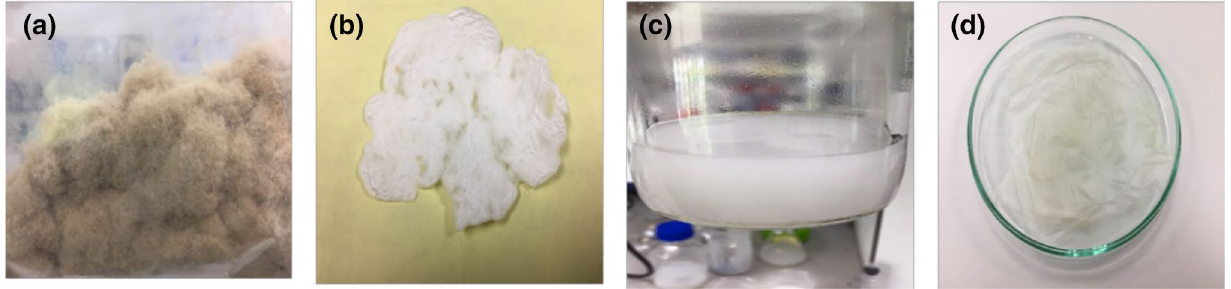
Fig. 1 Photographs of various forms of water hyacinth during the preparation a the cut and ground fibers, after washing with methanol, b the NaOH-extracted and H 2 O 2 -bleached fibers, c An aqueous solu-